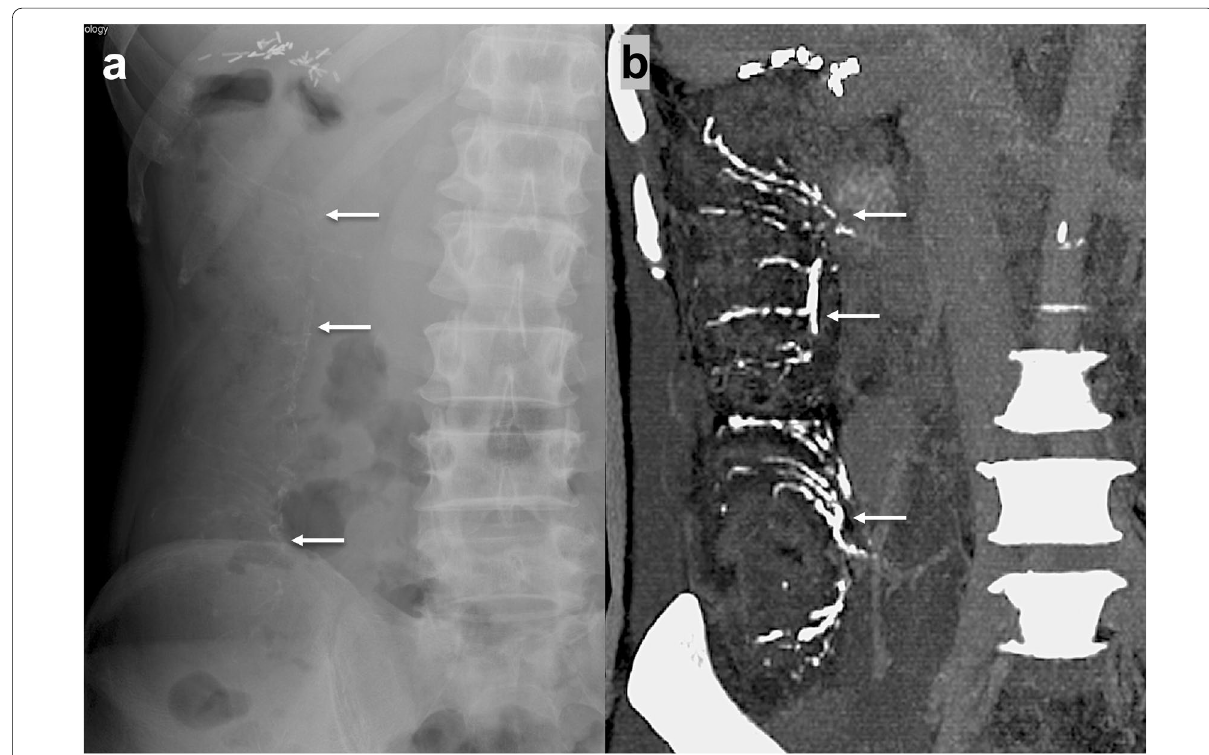
Fig. 5 a Curvilinear calcifications alongside the right colon seen on abdominal radiograph. b Corresponding maximum intensity projection display of CT angiography shows comprehensive demonstration of the calcified straight and marginal veins of the ascending